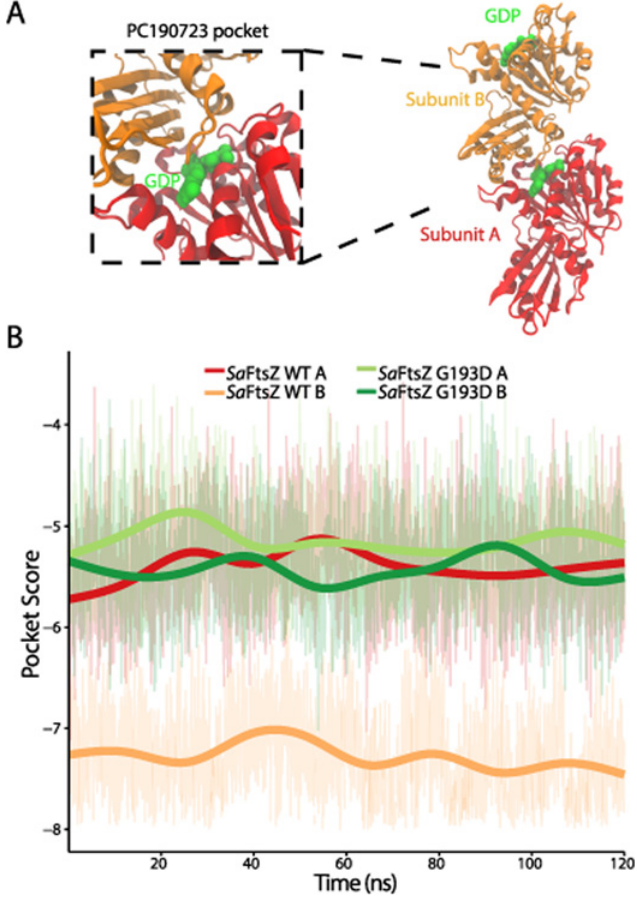
Fig 4. Pocket similarity score predicts that polymerization increases PC190723 binding affinity. (A) Geometry of the FtsZ dimer structure. FtsZ subunits were initialized from the GDP-bound S . aureus wild- type structure (PDB ID: 3VO8). (B) PocketFEATURE scores of the dynamic FtsZ dimer structure show that the PC190723-binding pocket close to the dimer interface has significantly more pocket similarity to the Sa FtsZ-PC190723 co-crystal than the more exposed pocket on the end of the dimer. Thick lines are smoothed versions of the raw data (Methods). WT,